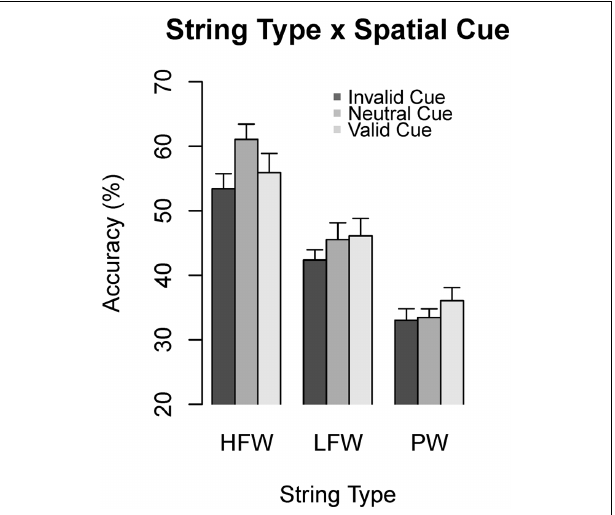
FIGURE 2 |Accuracy in string identification (percentage of correctly reported letters) as a function of type of string and validity of the spatial cue. Error bars represent standard error of the means (SEMs).